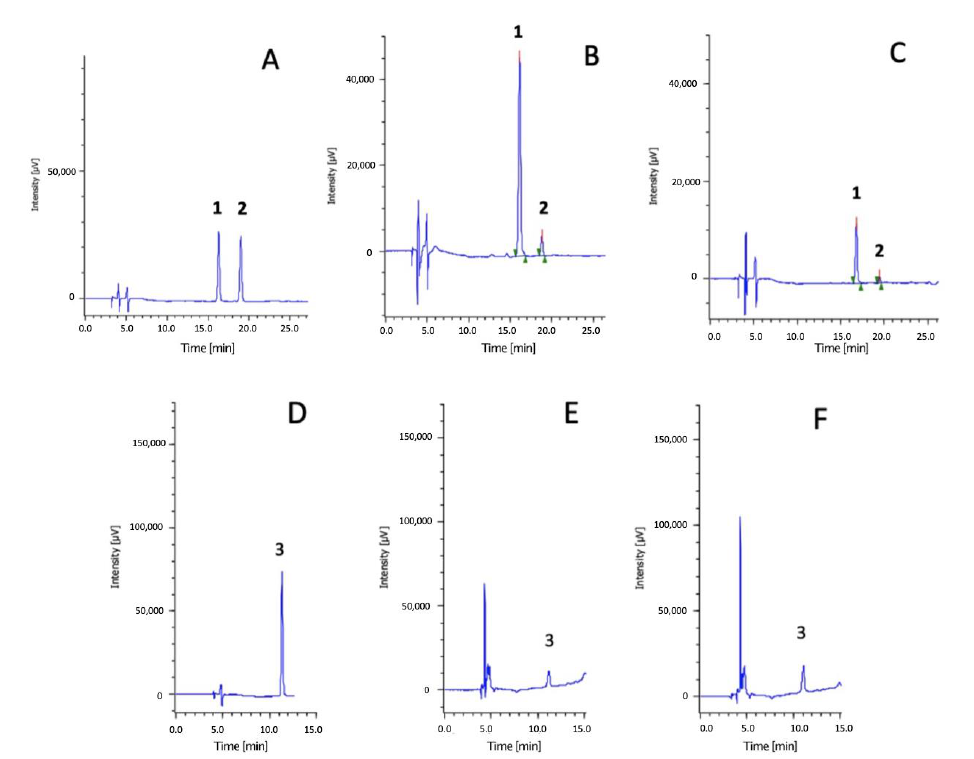
Figure 2. Chromatograms of ( A ) anthocyanin standard solution (5 µ g/mL); ( B ) Nerone extract before digestion, detection at 520 nm; ( C ) Nerone extract after digestion, detection at 520 nm; ( D ) protocatechuic acid (20 µ g/mL); ( E ) Nerone extract before digestion, detection at 280 nm; ( F ) Nerone extract after digestion, detection at 280 nm; (1) cyanidin-3- O -glucoside, (2) peonidin-3- O -glucoside, (3) protocatechuic acid. Table 2. Identification and quantification of anthocyanins and protocatechuic acid by the HPLC- DAD technique. Results are expressed as mean ± SD ( n = 3).